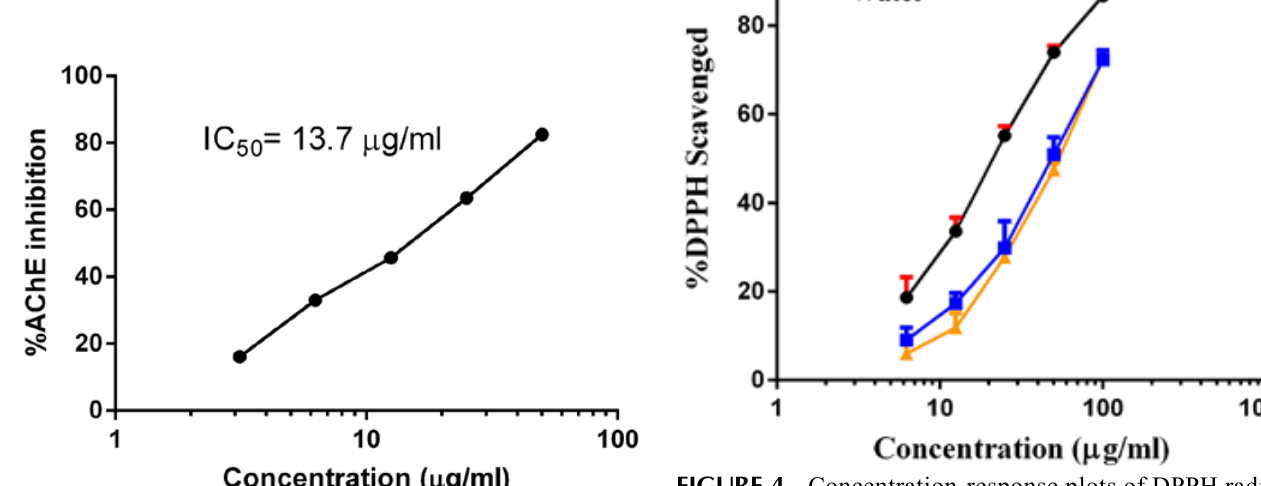
FIGURE 4 - Concentration-response plots of DPPH radical scavenging by different extracts from P. atropurpureus. Samples were tested for DPPH radical scavenging as described in the of the 50 methods section. Data are means of three experiments each run in